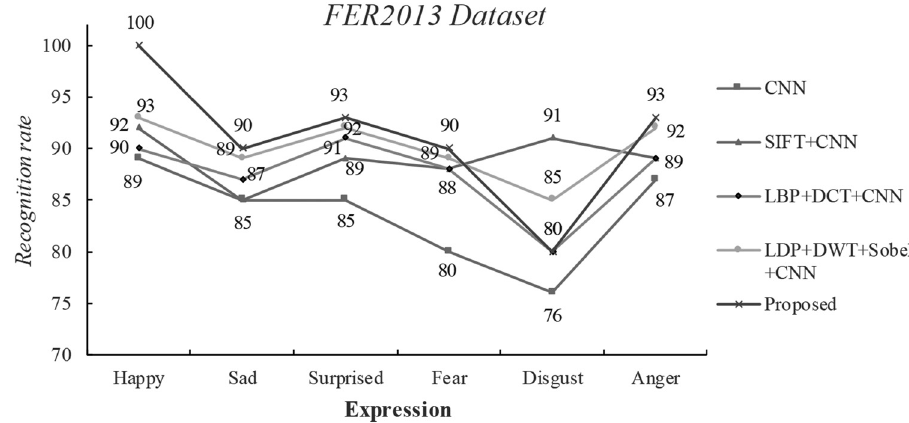
Figure 7: Result comparison of di ff erent algorithms in the FER2013 dataset.